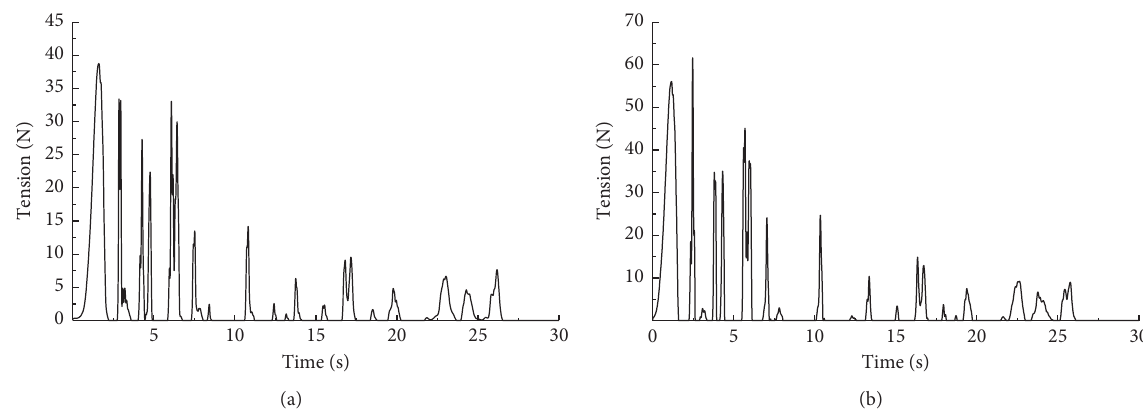
Figure 10: Time series of the tension at the bow and stern mooring lines when the ship is moored at position I with bow and stern moorings. (a) Time series of tension at bow mooring line. (b) Time series of tension at the stern mooring